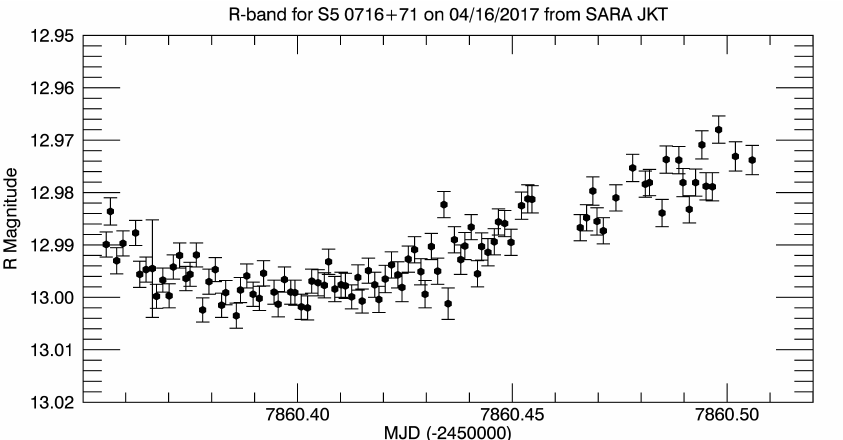
Figure 2. The light curve of S5 0716+71 in the R-band. Though some distinct short-term variability is present, no measurable pulses are seen.